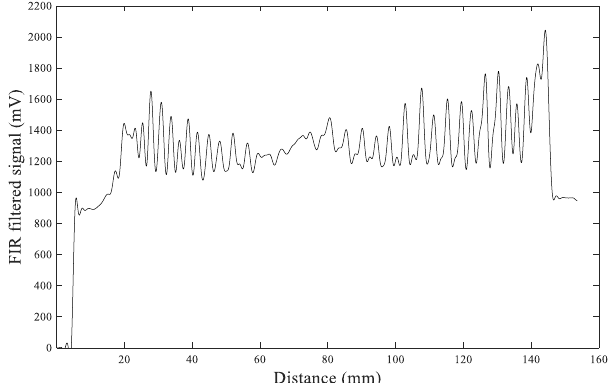
Figure 15. The waveform after FIR filter processing.